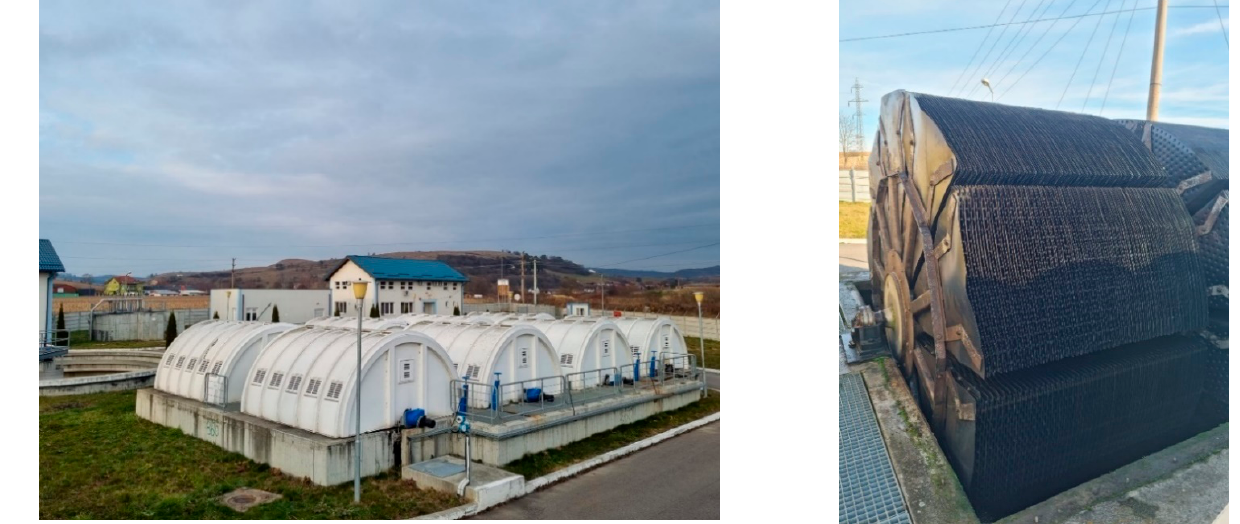
Figure 2. The RBCs of Agnita: the modules ( left ), and discs ( right ).